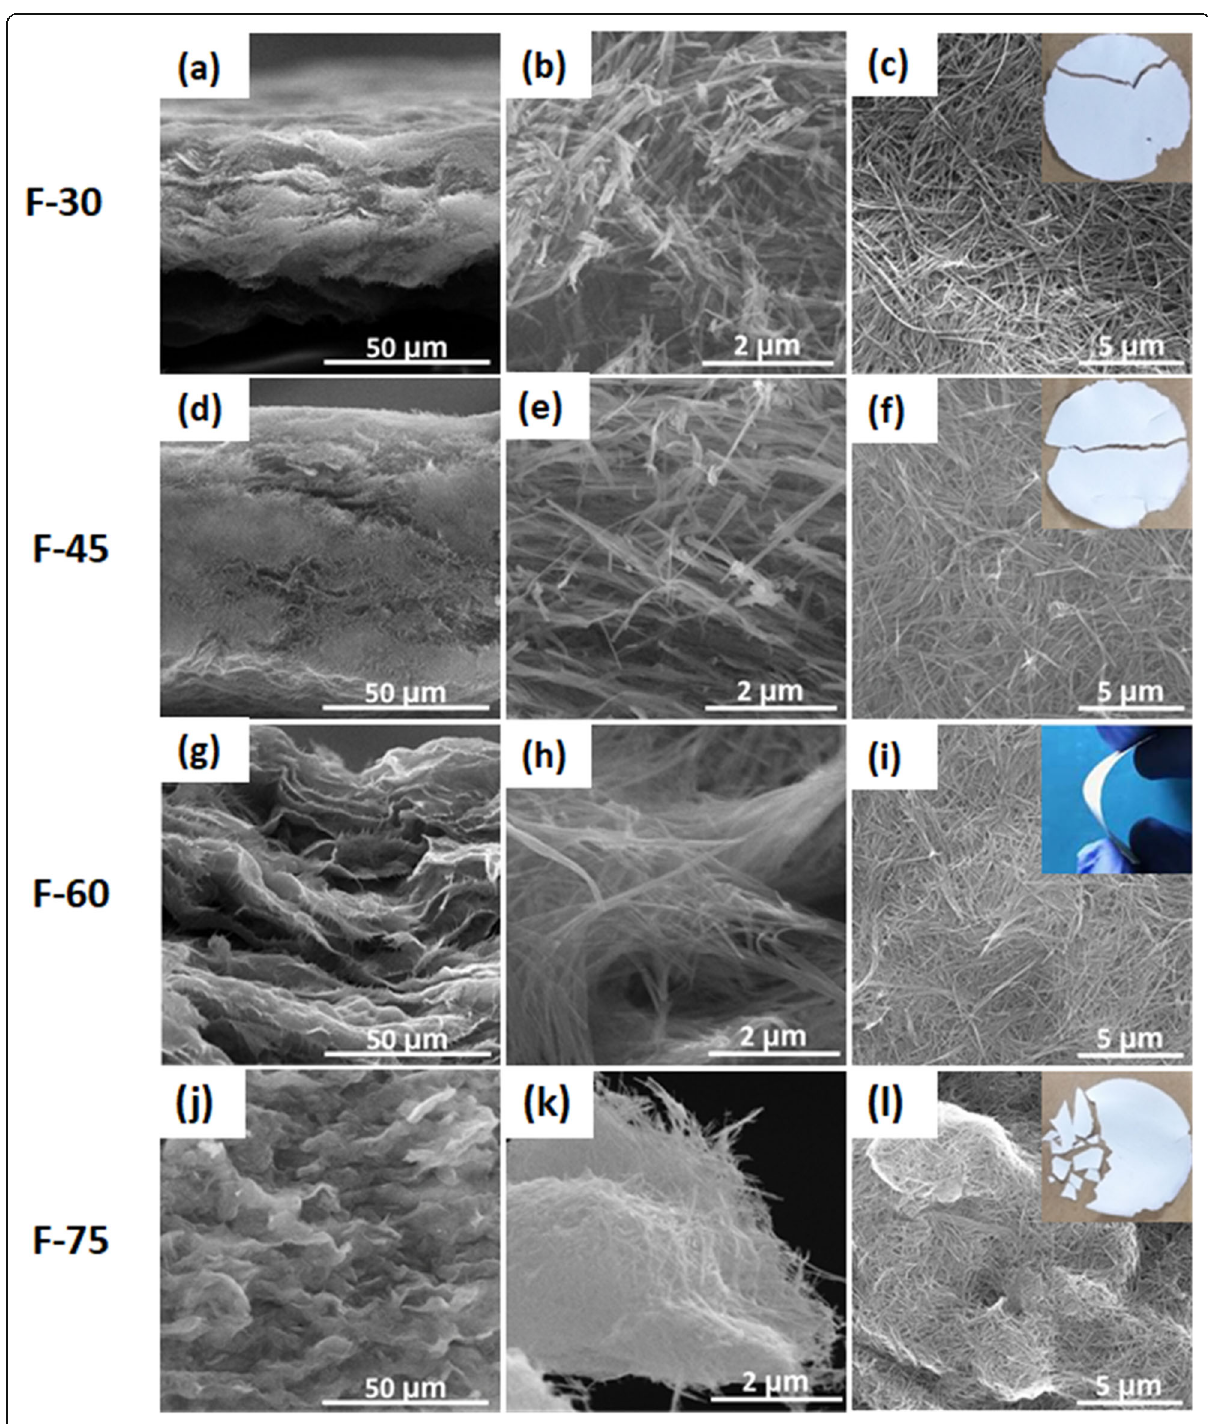
Fig. 3 SEM images of cross-section of F-30 ( a , b ), F-45 ( d , e ), F-60 ( g , h ), and F-75 ( j , k ). TEM images of top view of F-30 ( c ), F-45 ( f ), F-60 ( i ), and F-75 ( l ). The insets are the optical images of corresponding